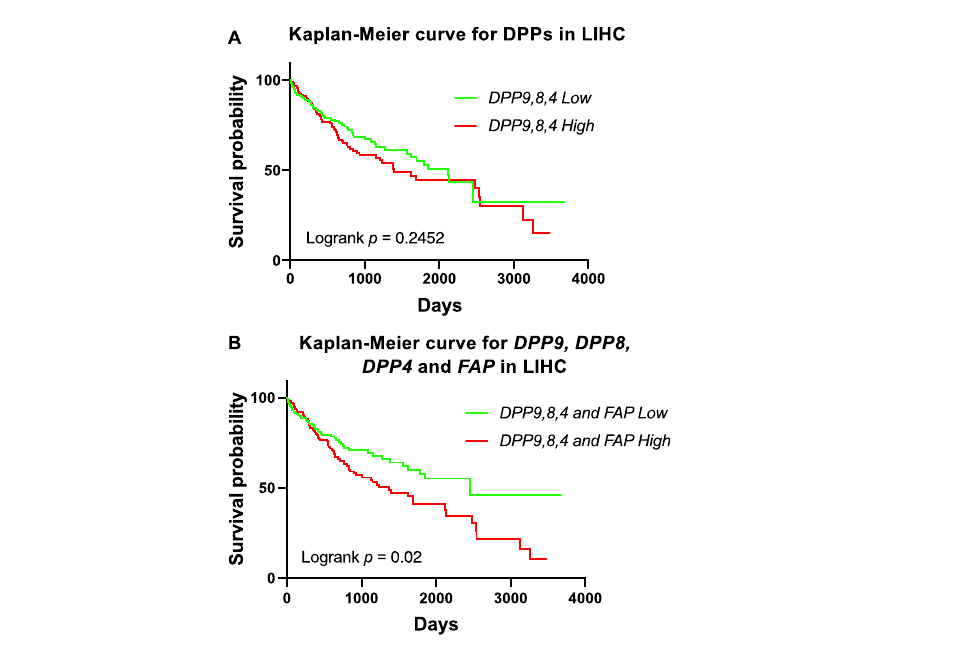
Figure 4. Survival analysis of high co-expression of DPP9, DPP8, DPP4 and FAP in HCC patients. (A ) Kaplan-Meier curve for high co-expression of DPP9, DPP8 and DPP4 in HCC patients ( n = 360). ( B ) Kaplan-Meier curve for high co-expression of DPP9, DPP8, DPP4 and FAP in HCC patients. The high (red) and low (green) mRNA expression levels of genes in liver tumors were stratified based on median expression value. p values were calculated by logrank (Mantel-Cox) test.